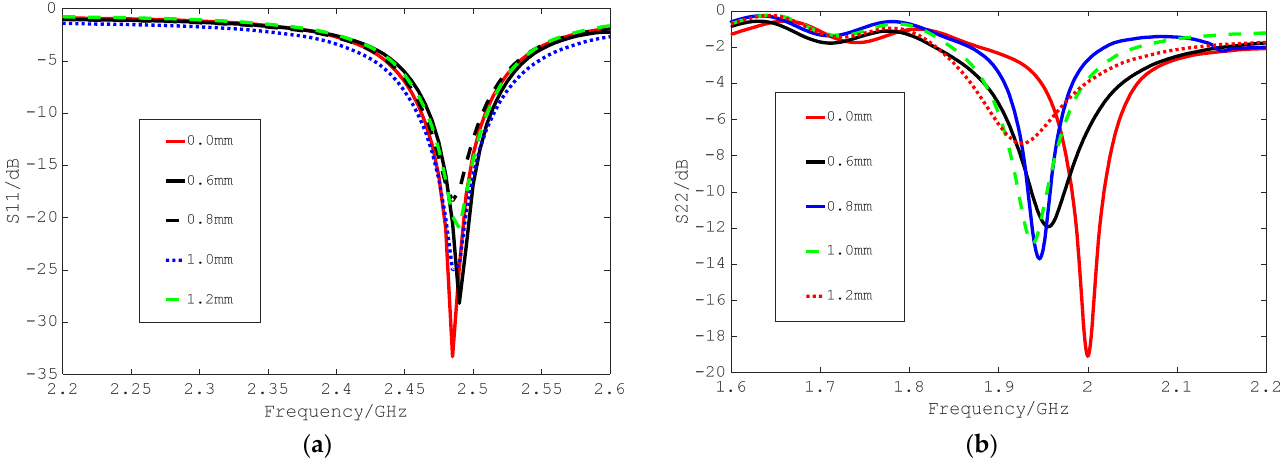
Figure 14. Measured reflection coefficient results of fabricated sensor for vertical crack with different widths. ( a ) Port 1. ( b ) Port 2.